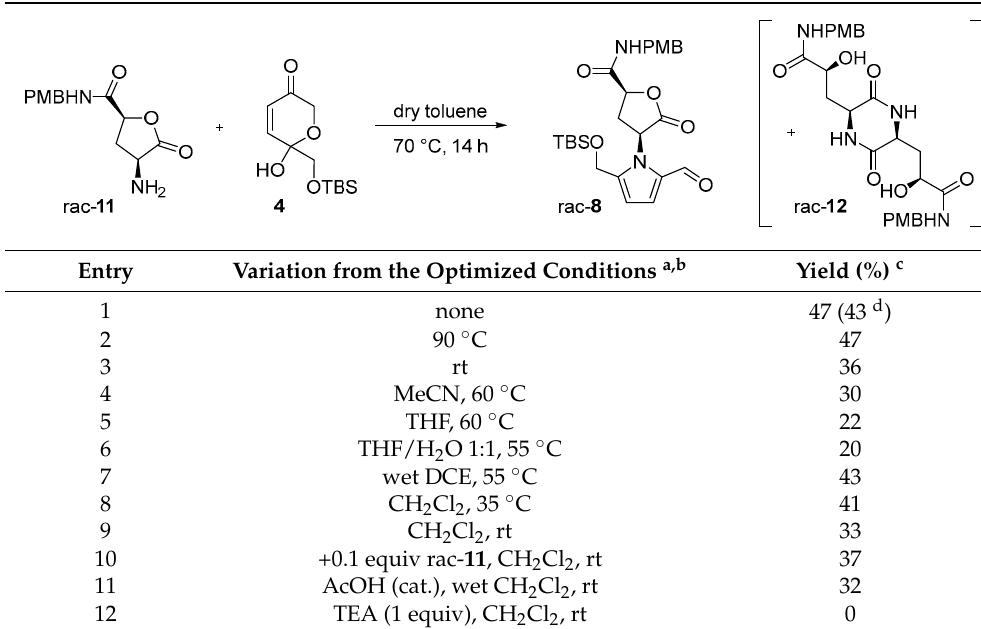
Table 1. Optimization of the Maillard reaction step.